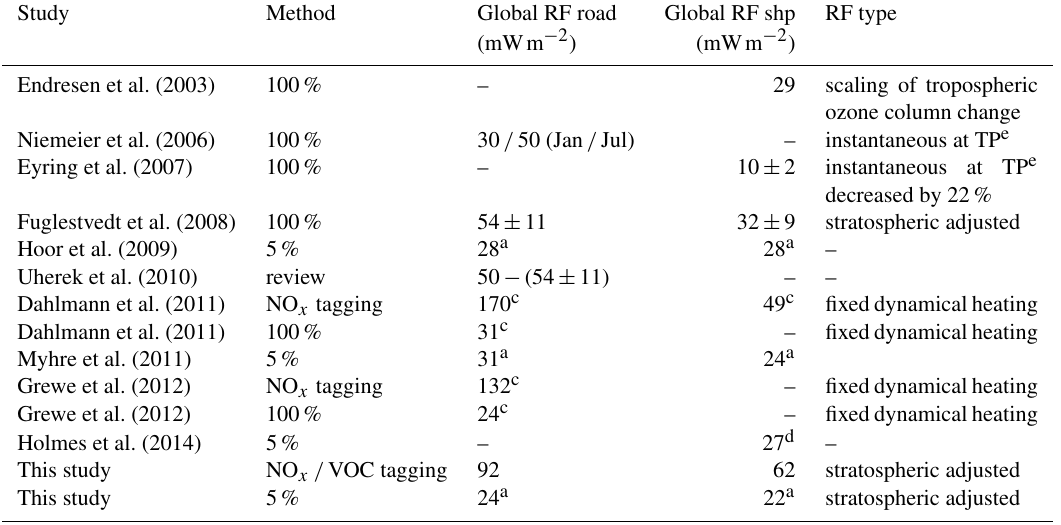
Table 8. Global estimates of the annually averaged radiative forcing due to O 3 caused by emissions of land transport and road traffic (global RF road) and ship emissions (global RF shp). Please note that individual studies use different methods for the calculation of the radiative forcing, e.g. some studies give instantaneous values, while other studies give stratospheric adjusted values (see last